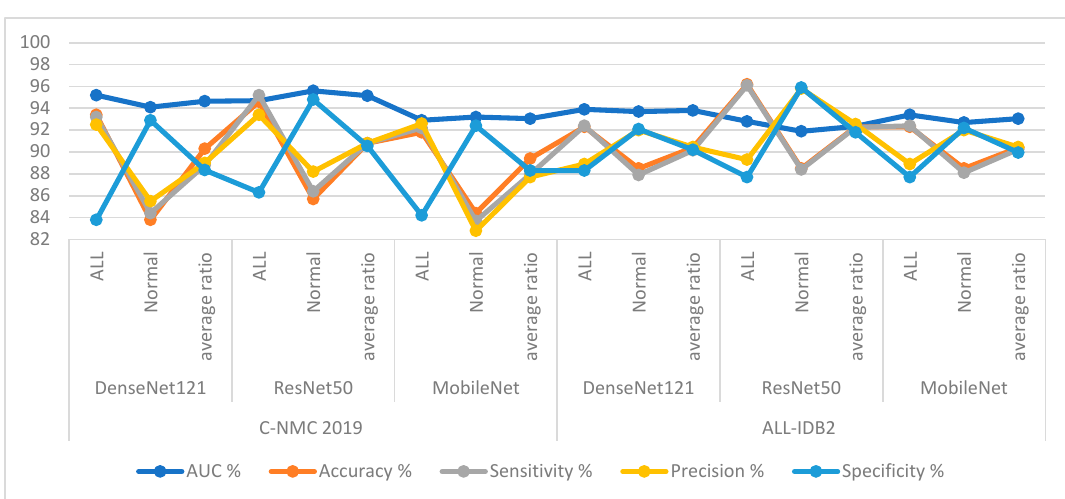
Figure 7. Display of results of CNN models of the C-NMC 2019 and ALL-IDB2 datasets for acute leukemia diagnosis.